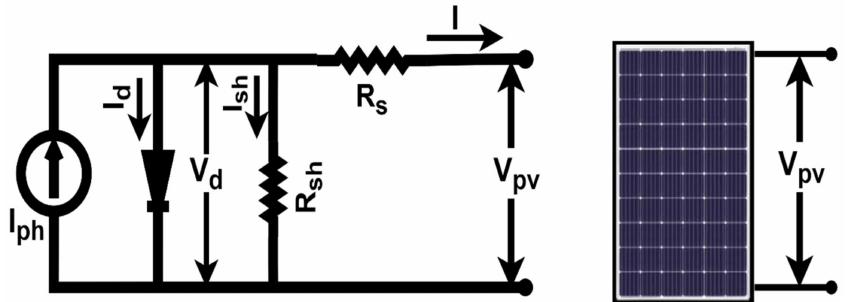
Figure 1. Circuit diagram of a PV